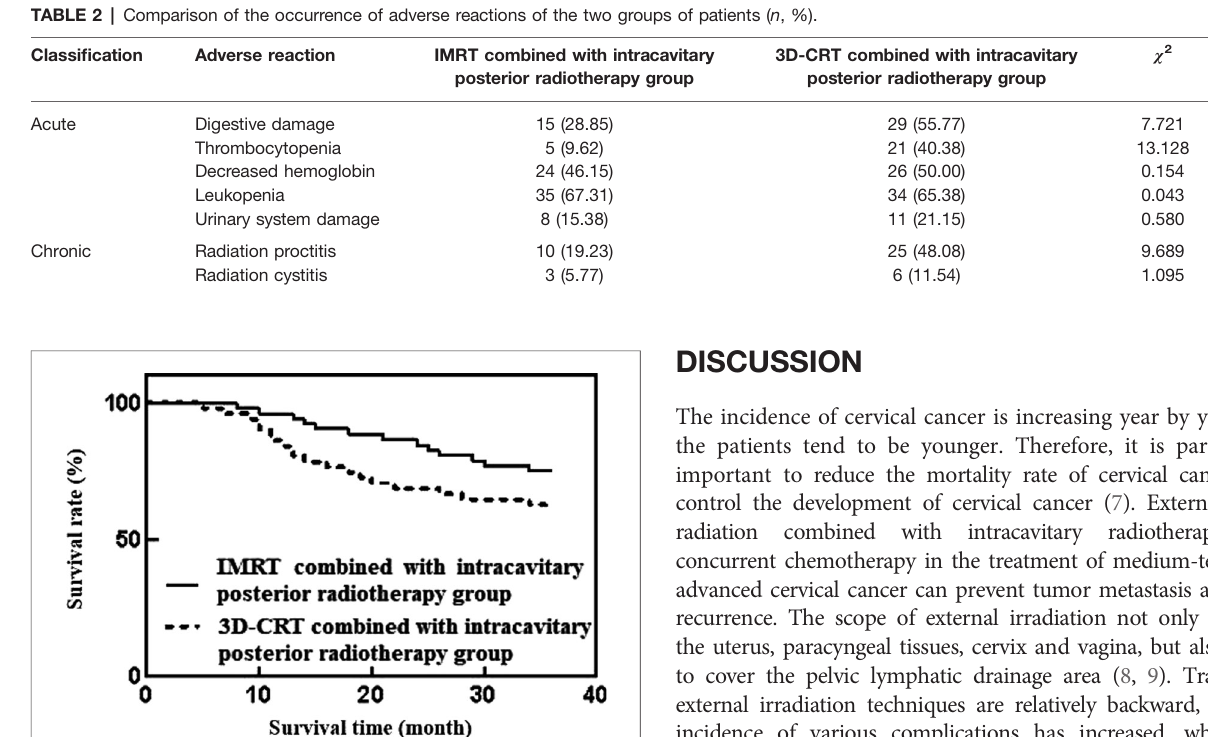
FIGURE 1 | Comparison of prognosis and survival between the two groups of